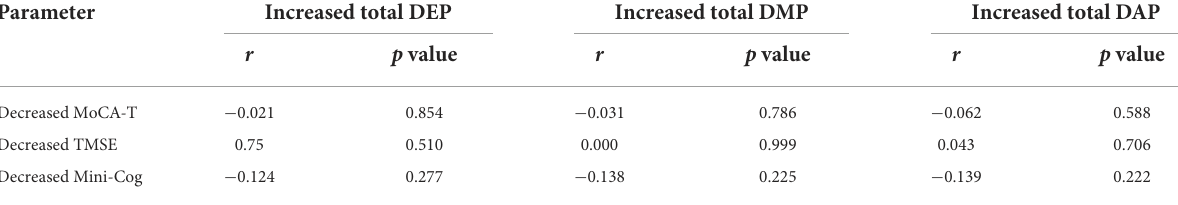
TABLE 5 Spearman rank correlation coefficient ( r ) between increased urinary OP metabolite levels and cognitive decline.